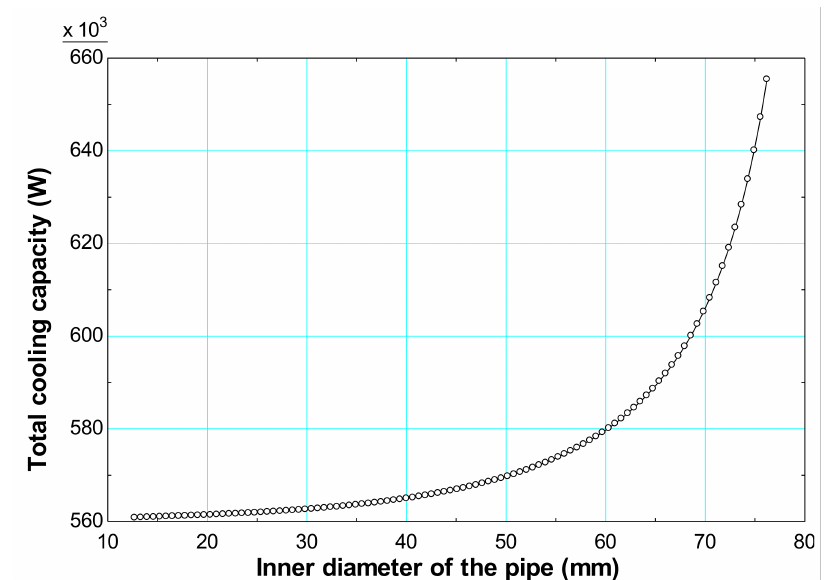
Figure 7. Total cooling capacity with different pipe inner diameters.